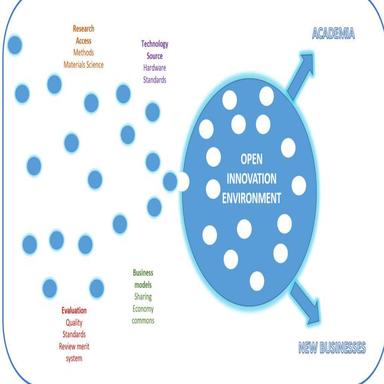
Schematic figure of a web based Open Innovation Environment operation: metadata/data from experimental and modeling processes and their interpretation will provide standardized protocols (e.g. in nanoindentation and contact mechanics) in a specific dedicated platform which will enable faster retrieval of information from businesses and avoid costly duplicate experiments from academia.